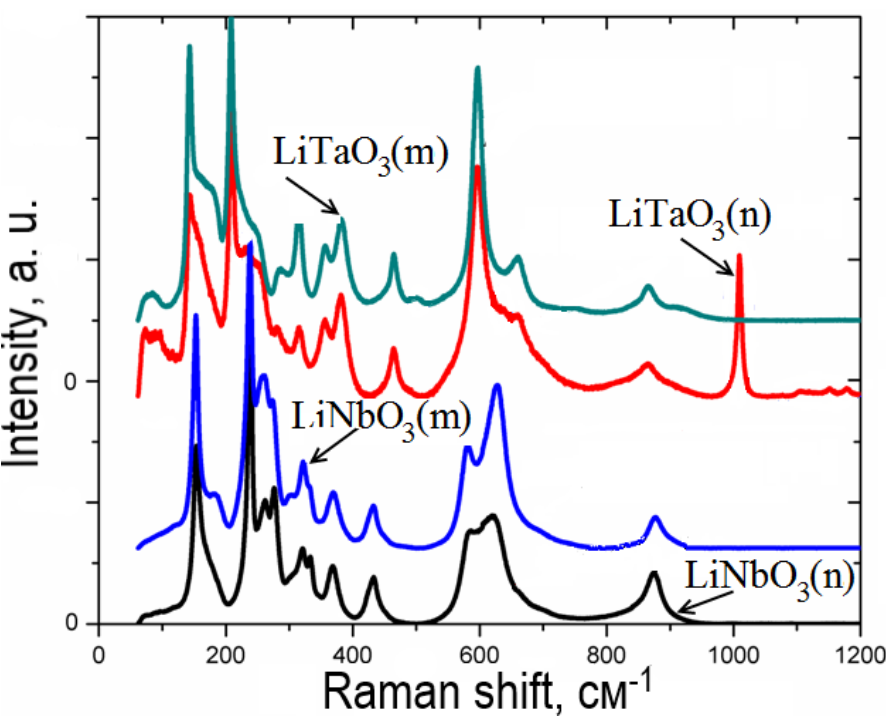
Figure 10. Raman spectra of nanopowders (n) of LiNbO cal treatment and the ones of micropowders (m) of LiNbO 3 and LiTaO 3 obtained by crushing.